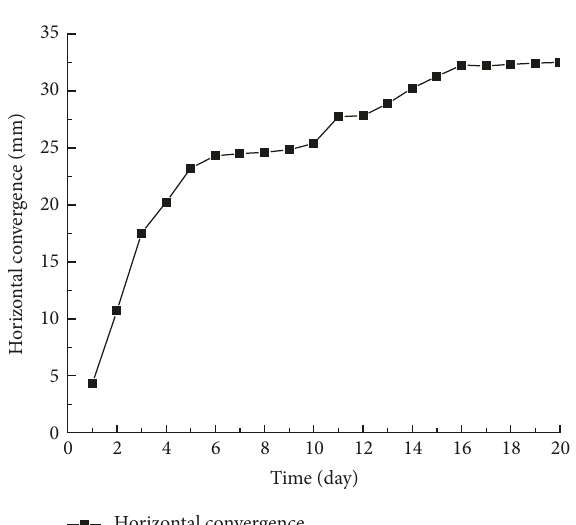
Figure 8: Layout of the observation piles.